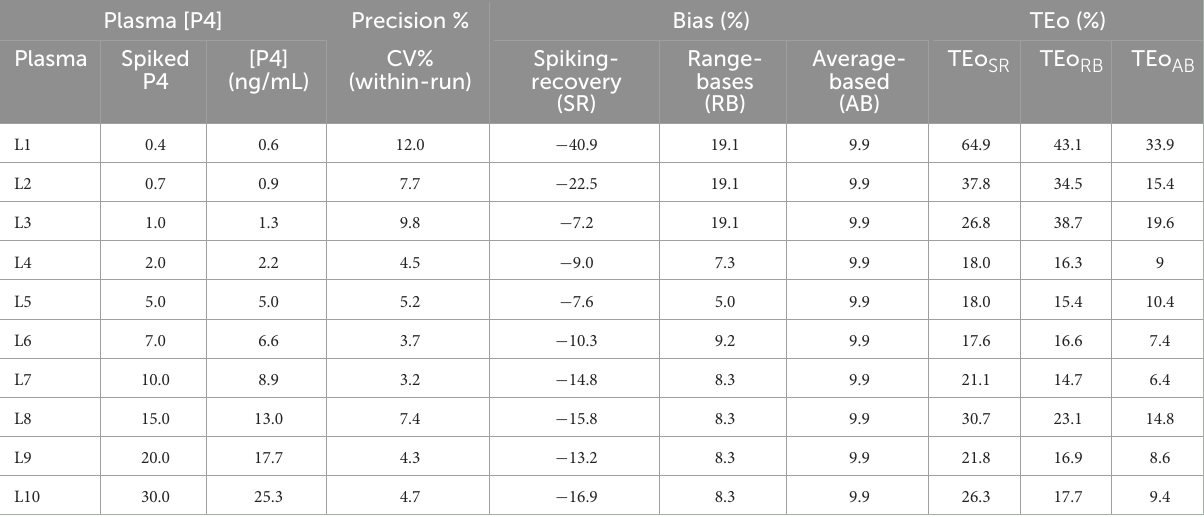
TABLE 1 Coefficient of variation (CV; within-run), bias, and observed total error (TEo) percentages results of IMMULITE ® 2000 XPi P4 immunoassay across the spiked plasma progesterone